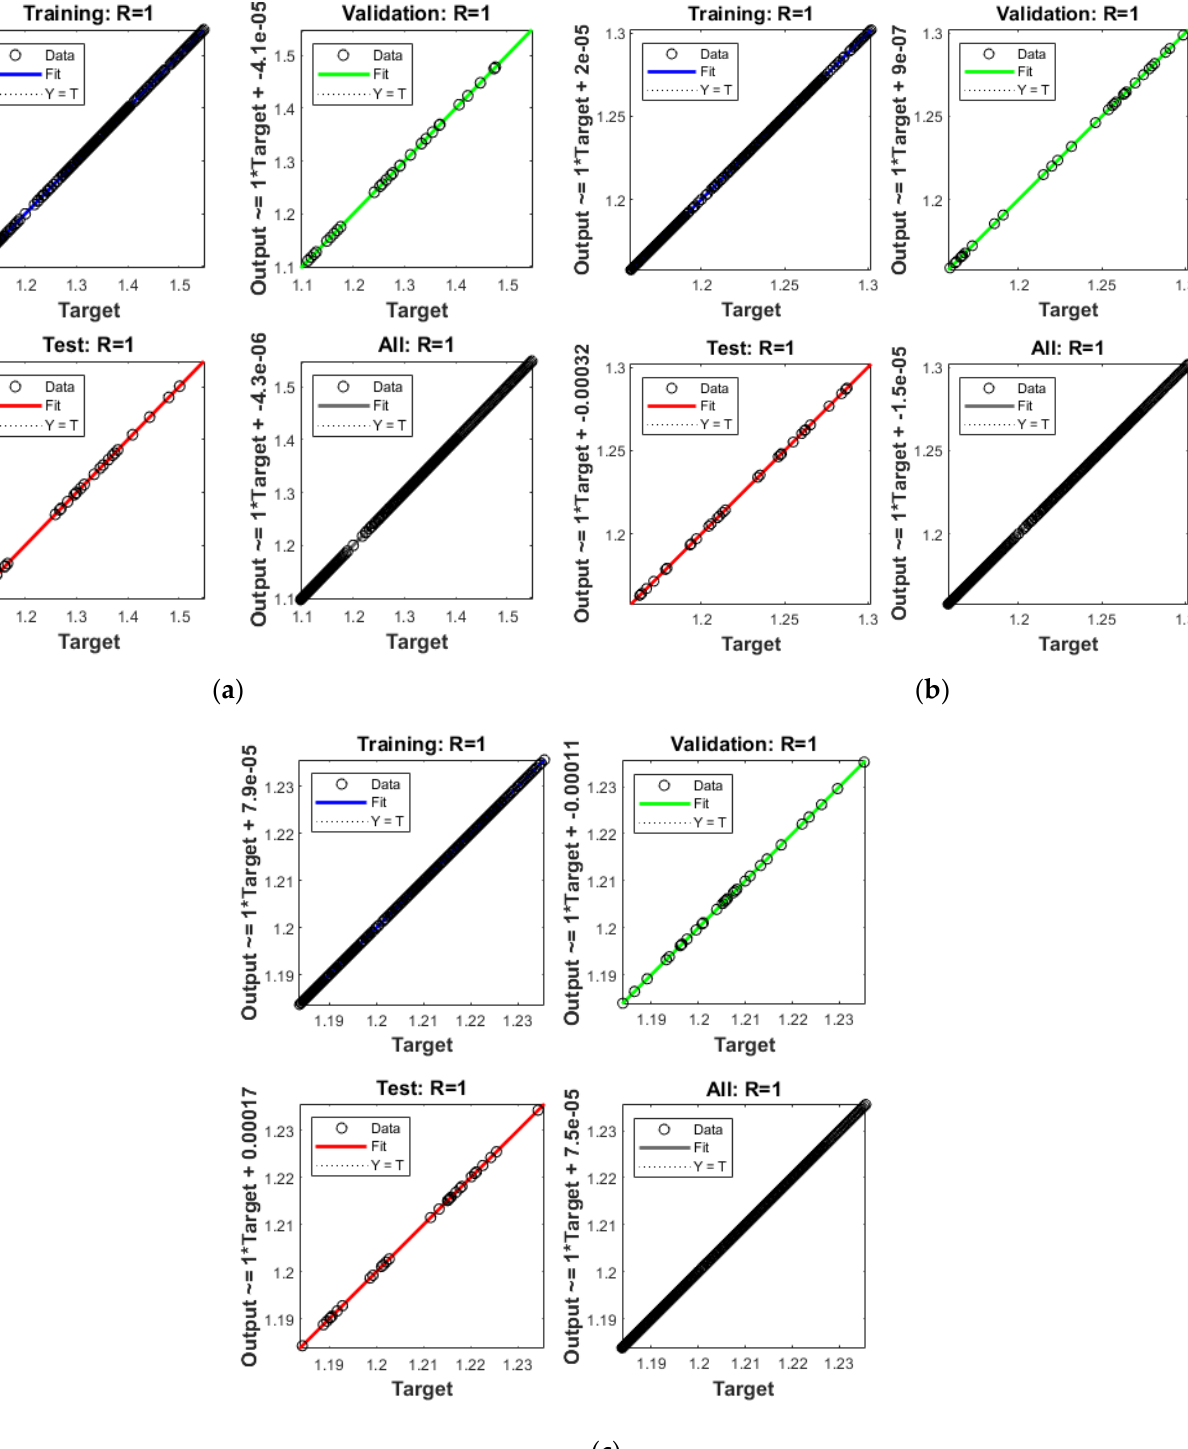
Figure 5. Regression performances for the mathematical form of the FKFS model. ( a ) Regression for C-1 ; ( b ) Regression for C-2; ( c ) Regression for C-3 .